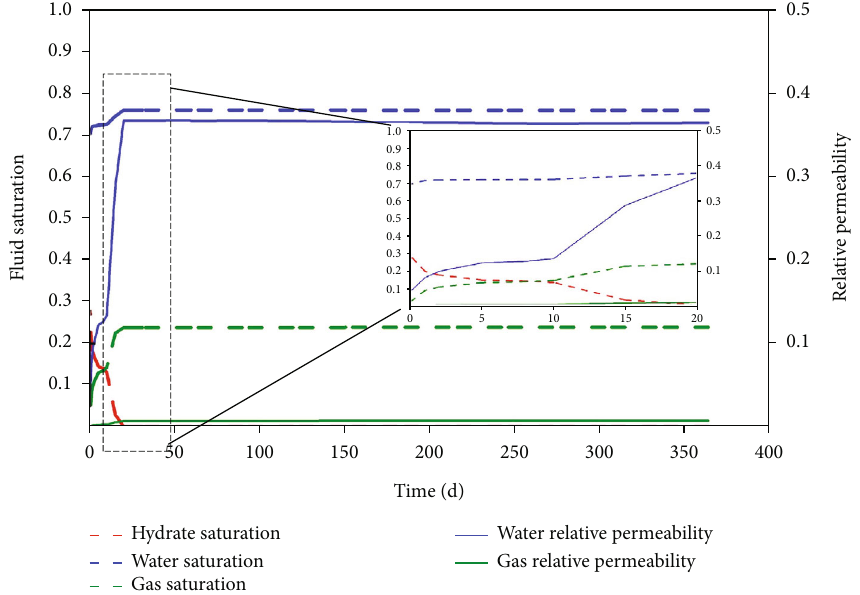
Figure 16: The variations of the water and gas relative permeability 1m from the